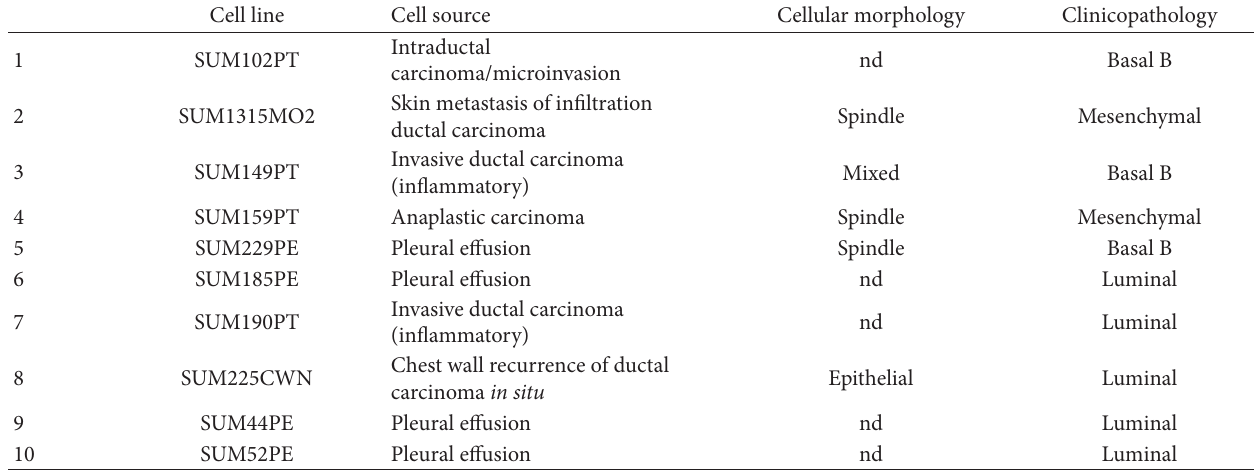
T 1: Cell source and clinicopathological characteristics SUM cell lines provided by